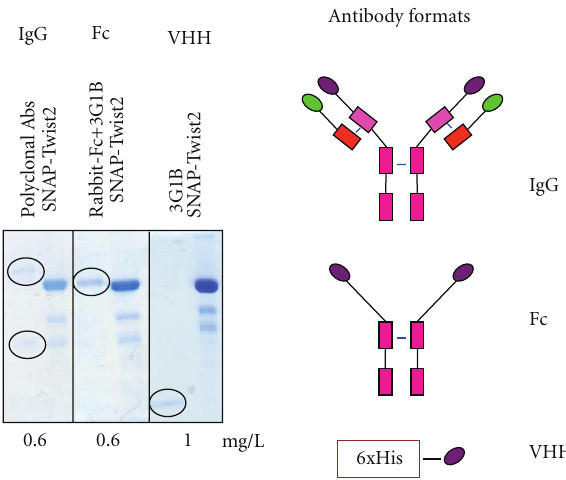
Figure 3: Comparison of the protein yields obtained by immunop- urification using di ff erent antibody formats. The protein SNAP- Twist2 was immunopurified from total lysate using sepharose columns to which the following antibodies were covalently linked: llama IgG anti-SNAP polyclonal antibodies; 6xHis tagged llama recombinant antibody 3G1B in VHH format; the same 3G1B antibody fused to the rabbit Fc